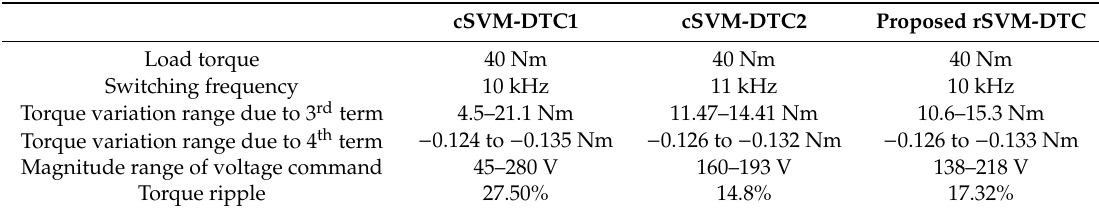
Table 2. Comparison of the simulation results for different methods.